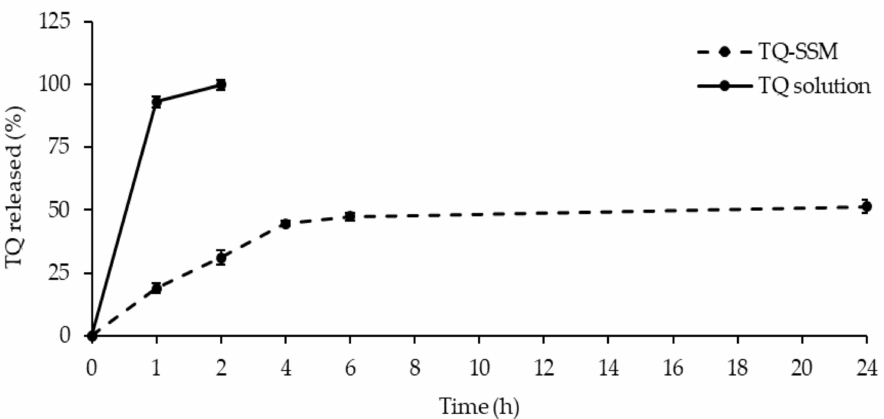
Figure 3. In vitro release profiles in PBS (pH 7.4) of TQ from aqueous saturated solution (TQ) and from micelles TQ-SSM.